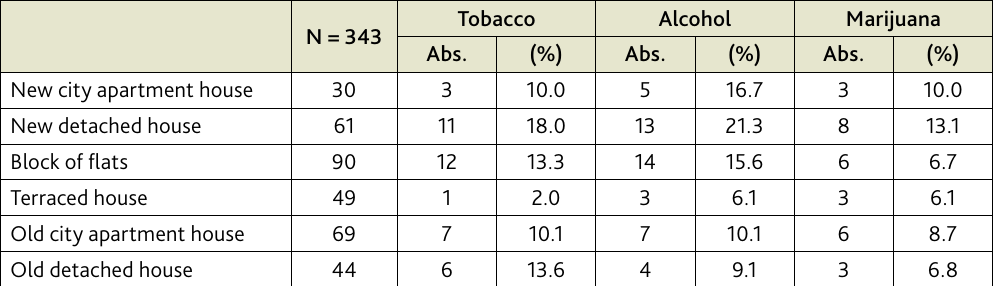
Figure 3. Percentage of respondents at-risk consuming tobacco, alcohol or marijuana Source: Own research Table 2. Percentage of respondents at-risk consuming tobacco, alcohol or marijuana, based on types of housing development